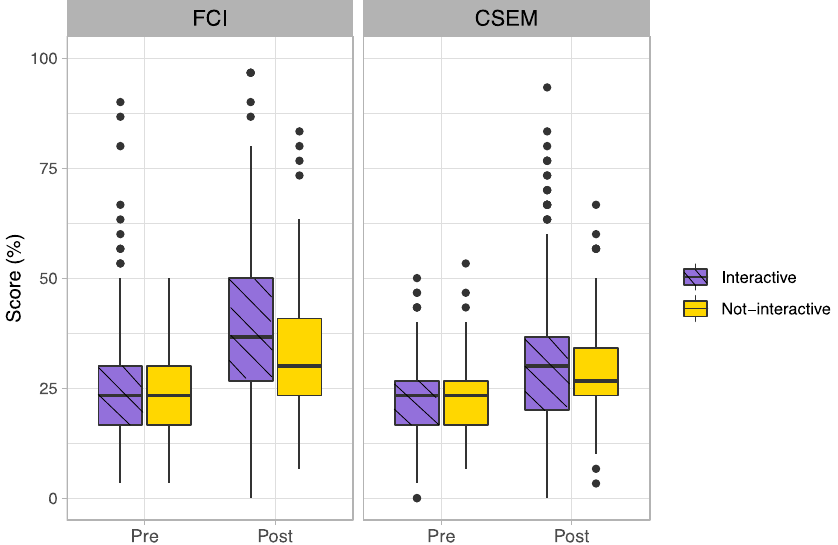
FIG. 11. Pretest and posttest scores on FCI and CSEM for undergraduate students who had GTAs with different regular instructional approaches. Student performance on FCI posttest is correlated with GTA regular instructional approach; while there is no correlation between student performance on CSEM posttest and GTA regular instructional